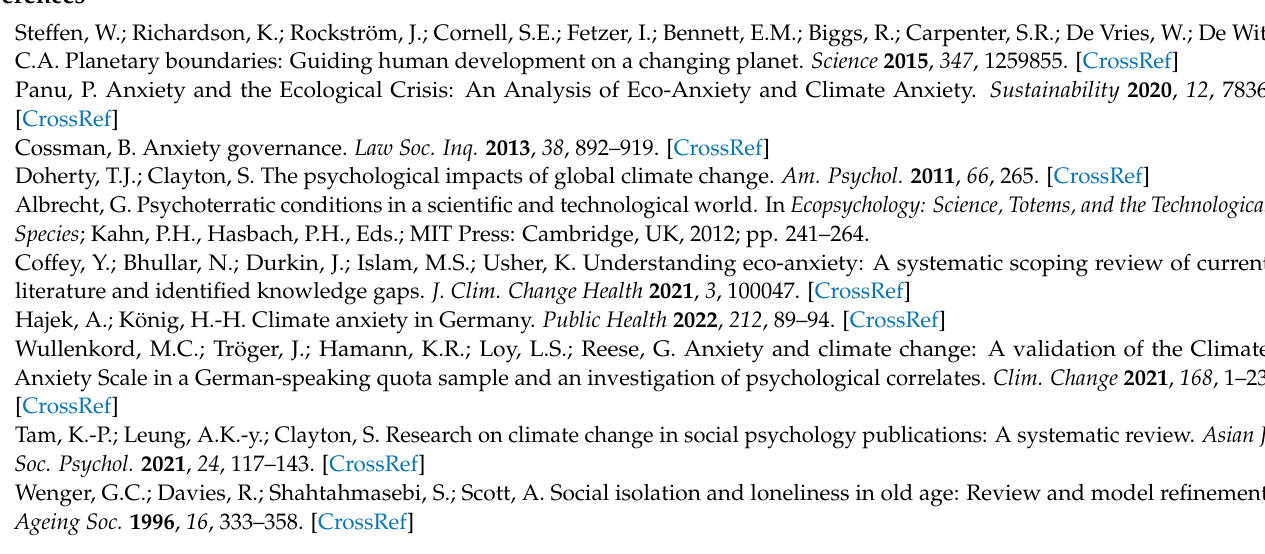
( η 2 and partial η 2). Loneliness as outcome and among the total sample. Table S2: Effect sizes for linear regression ( η 2 and partial η 2). Loneliness as outcome and among individuals aged 18 to 29 years. Table S3: Effect sizes for linear regression ( η 2 and partial η 2). Loneliness as outcome and among individuals aged 30 to 49 years. Table S4: Effect sizes for linear regression ( η 2 and partial η 2). Loneliness as outcome and among individuals aged 50 to 64 years. Table S5: Effect sizes for linear regression ( η 2 and partial η 2). Loneliness as outcome and among individuals aged 65 to 74 years. Table S6: Effect sizes for linear regression ( η 2 and partial η 2). Perceived social isolation as outcome and among the total sample. Table S7: Effect sizes for linear regression ( η 2 and partial η 2). Perceived social isolation as outcome and among individuals aged 18 to 29 years. Table S8: Effect sizes for linear regression ( η 2 and partial η 2). Perceived social isolation as outcome and among individuals aged 30 to 49 years. Table S9: Effect sizes for linear regression ( η 2 and partial η 2). Perceived social isolation as outcome and among individuals aged 50 to 64 years. Table S10: Effect sizes for linear regression ( η 2 and partial η 2). Perceived social isolation as outcome and among individuals aged 65 to 74 years. Table S11: Climate anxiety and loneliness as well as perceived social isolation (total sample and stratified by age group). Results of multiple linear regressions—additionally displaying all covariates; Table S12: Climate anxiety and loneliness as well as perceived social isolation (total sample and stratified by age group). Results of multiple linear regressions—additionally displaying all covariates and reporting standardized